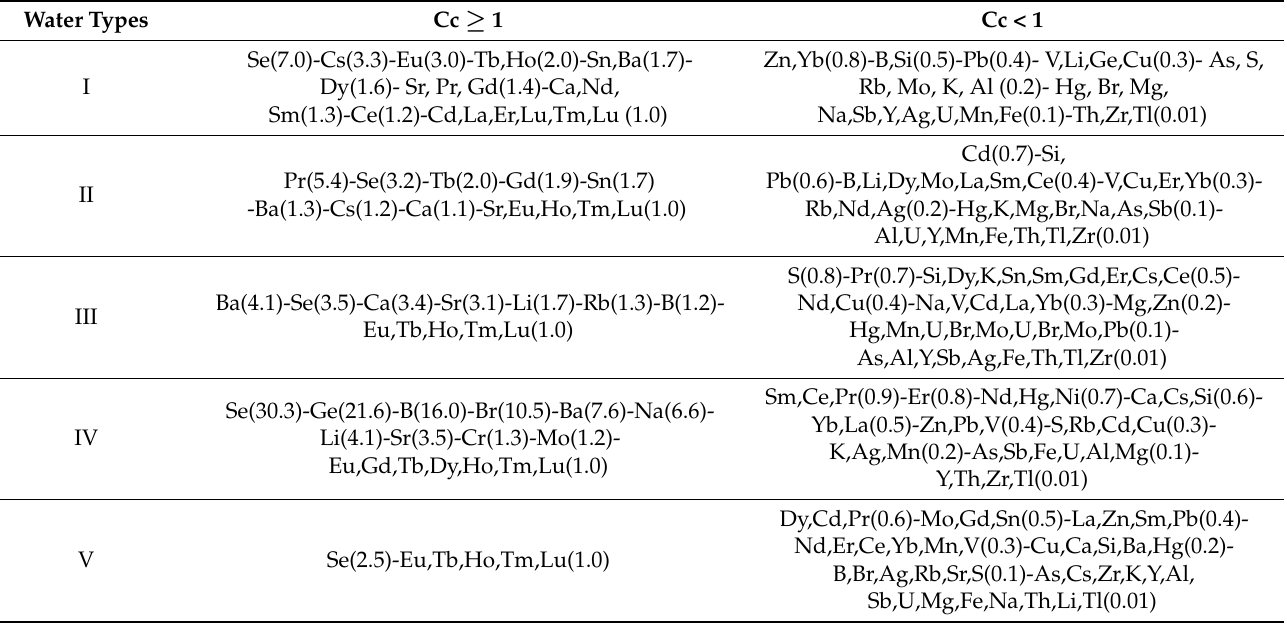
Table 2. Clarke concentrations of elements in different types of groundwater (Cc values in